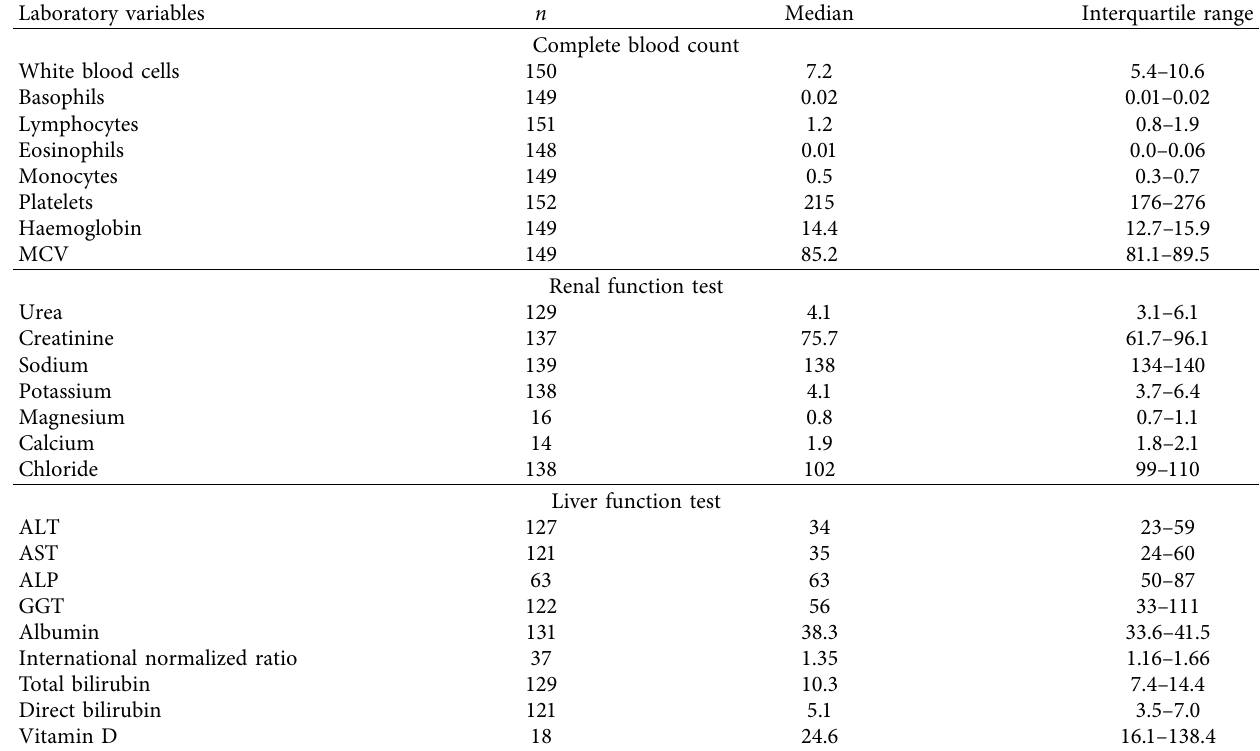
Table 2: Median laboratory parameters among COVID-19 patients admitted at case